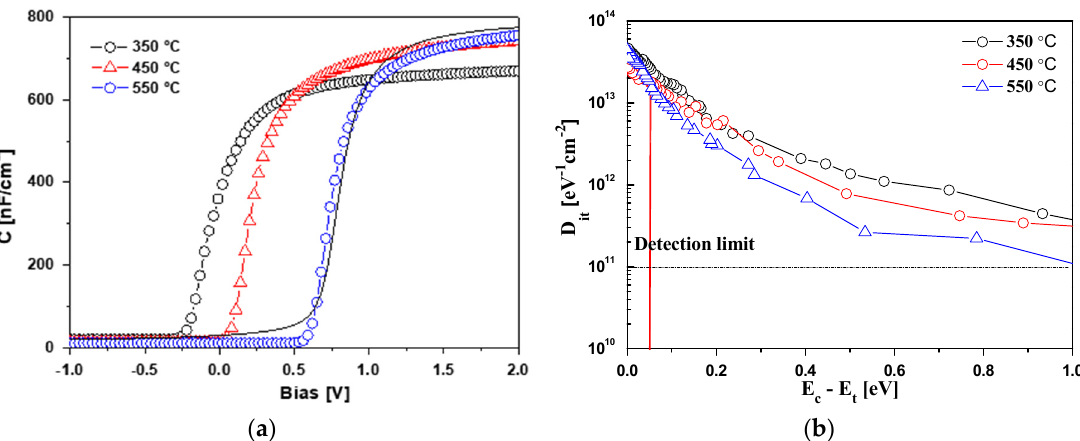
Figure 6. ( a ) C – V characteristics of the Al 2 O 3 /GaN MIS capacitor and ( b ) interface state density distributions of the Al 2 O 3 /GaN MIS capacitors by varying the ALD growth temperature from 350 ° C to 550 ° C .